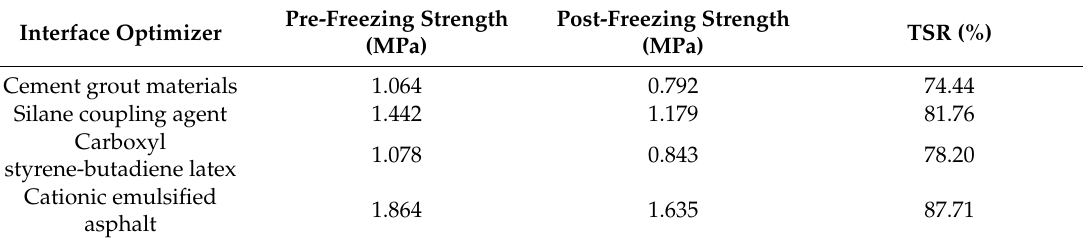
Table 12. Results of freeze-thaw splitting